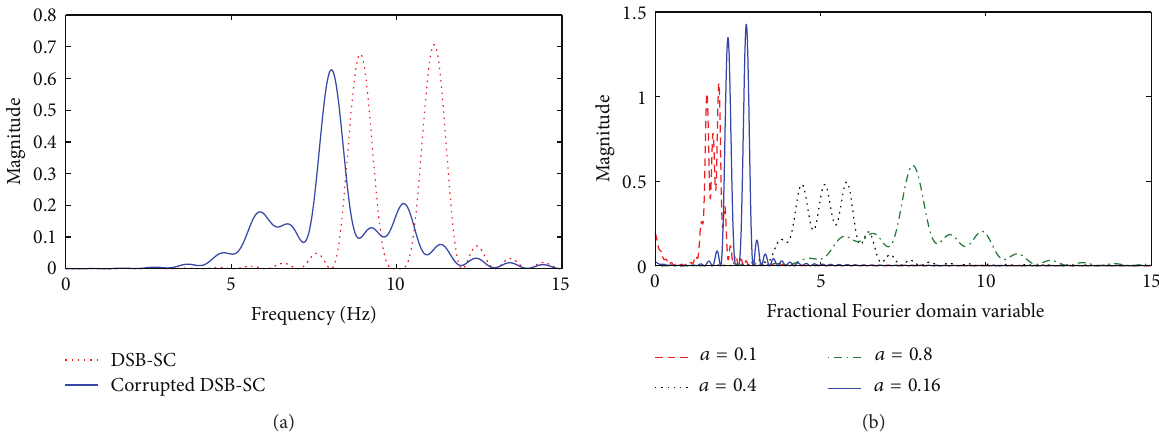
Figure 2: Removal of Doppler component introduced in DSB-SC signal. (a) FRFT of weighted autocorrelation of DSB-SC signal and corrupted DSB-SC signal at the FRFT order of 𝑎 = 1 (i.e., Fourier transform domain) and (b) FRFT of weighted auto-correlation of corrupted DSB-SC signal at different FRFT